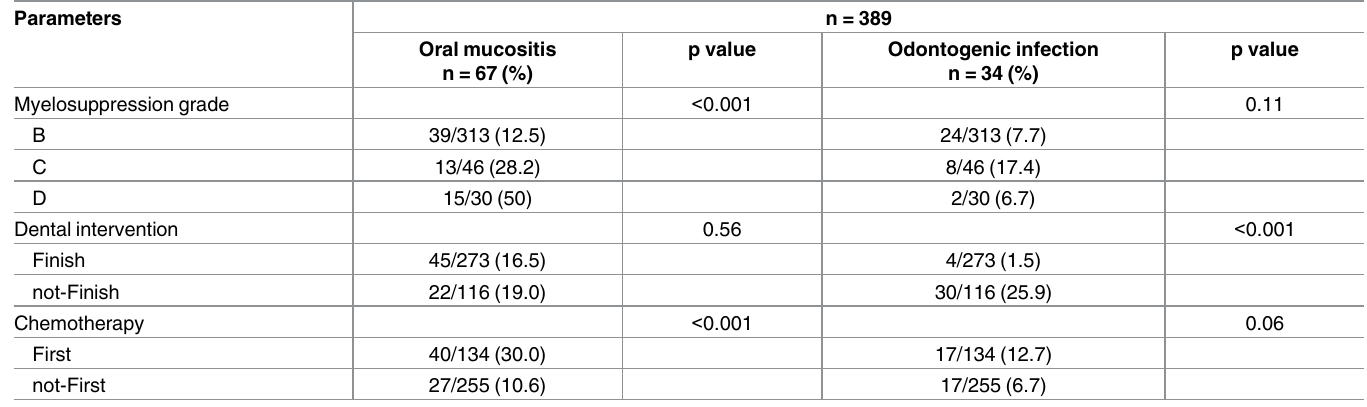
Table 3. Relationship between parameters and oral complications.